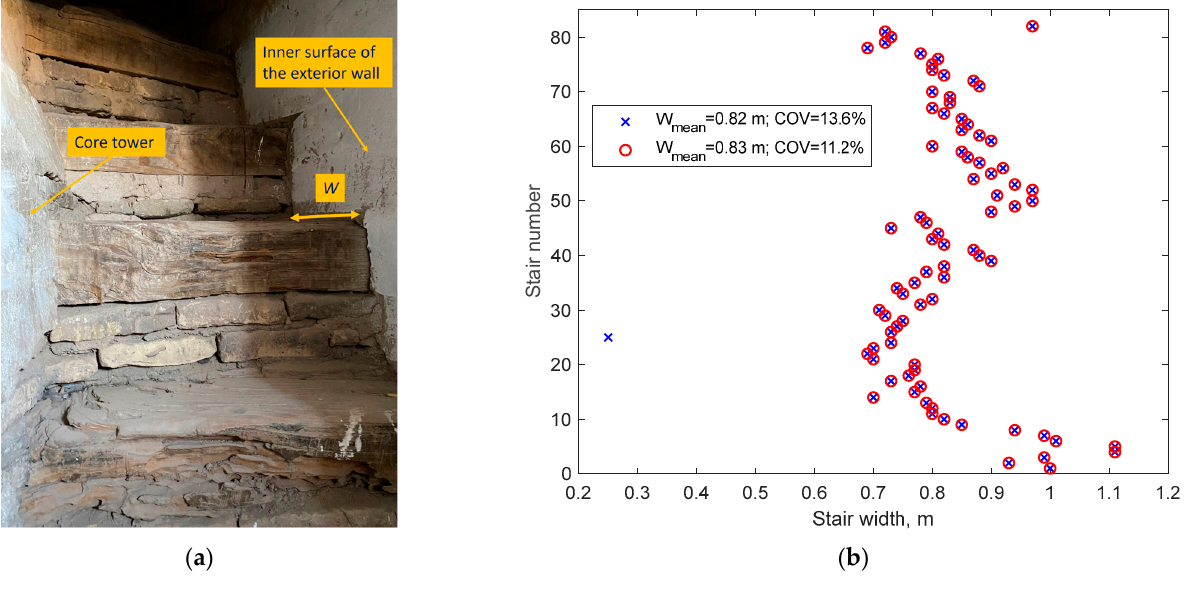
Figure 9. Width measurements of each stair: ( a ) schematic of measuring procedure; ( b ) widths of all stairs.